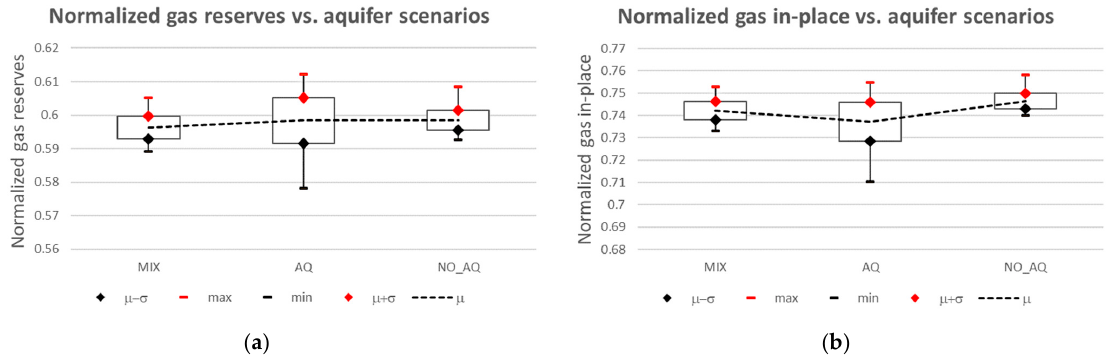
Figure 8. The uncertainty around the gas reserves and in-place volumes, history-matching using one year of production data and final ensemble with the best history match quality—various aquifer scenarios. ( a ) Gas reserves, ( b ) in-place volumes.